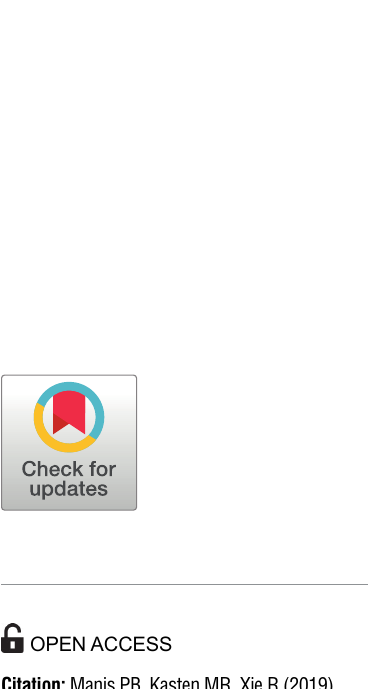
figshare.8854352.v1.The repositoryincludes